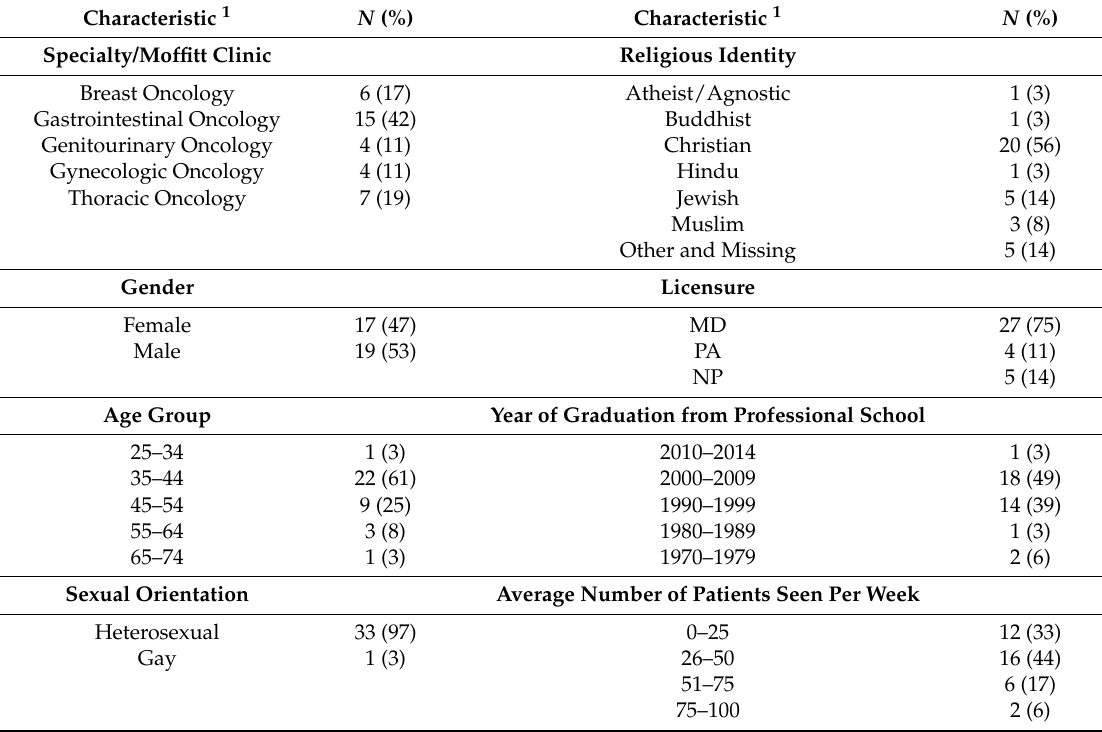
Table 1. Provider demographics in indicated specialties ( N =